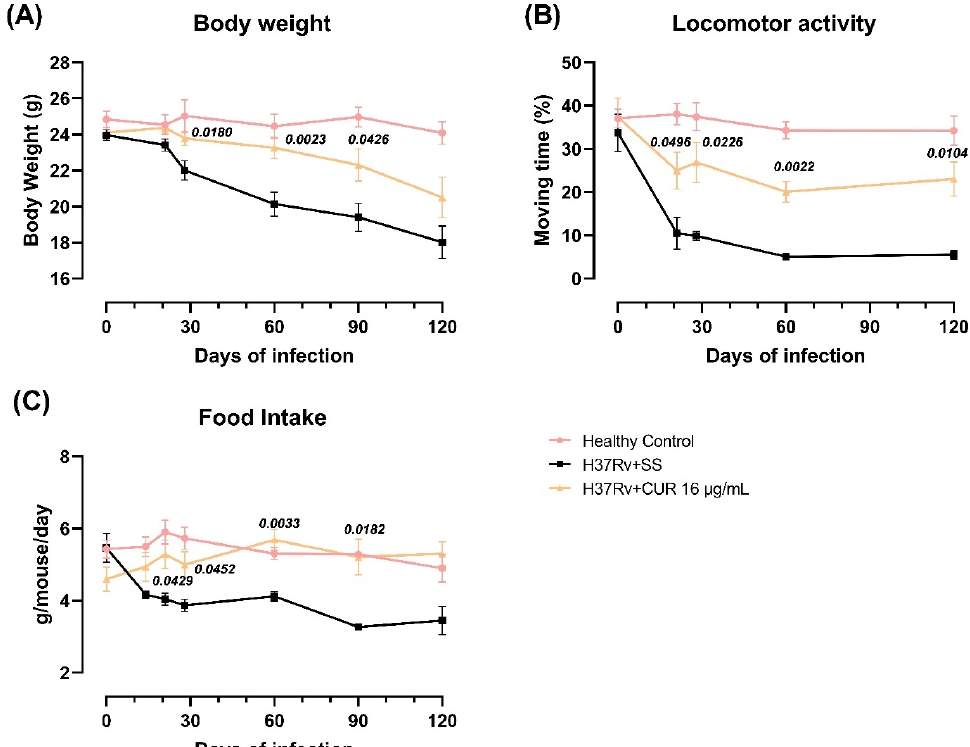
Figure 5. Effect of curcumin (CUR) treatment (16 μ g/mL) on sickness behavior in TB mice. ( A ) Bodyweight loss of infected animals that received CUR, control mice that only received saline solution (SS) as the vehicle, and healthy mice without infection. F (2, 400) = 42.71, p < 0.0001. Two-way ANOVA. Dunnett’s multiple comparisons test. ( B ) Locomotor activity of infected animals that received CUR, control mice that only received SS as the vehicle, and healthy mice without infection. F (2, 15) = 69.23, p < 0.0001. Two-way ANOVA. Dunnett’s multiple comparisons test. ( C ) Food intake of infected animals that received CUR, control mice that only received SS as the vehicle, and healthy mice without infection. F (2, 15) = 13.72, p < 0.0004. Two-way ANOVA. Dunnett’s multiple comparisons test. Data are presented as mean ± SEM ( n = 6/day/group). The treatment with CUR decreased the sickness behavior of infected animals. There was an improvement in body weight, increased locomotor activity, and increased food